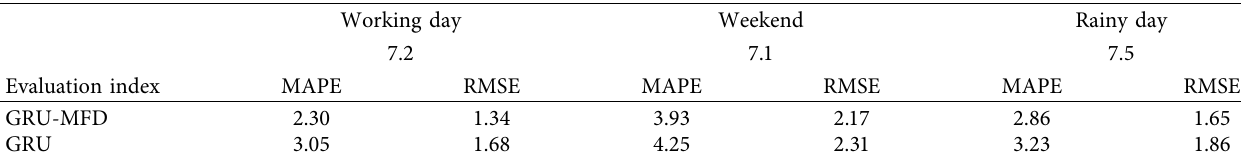
Table 5: Section 1 prediction